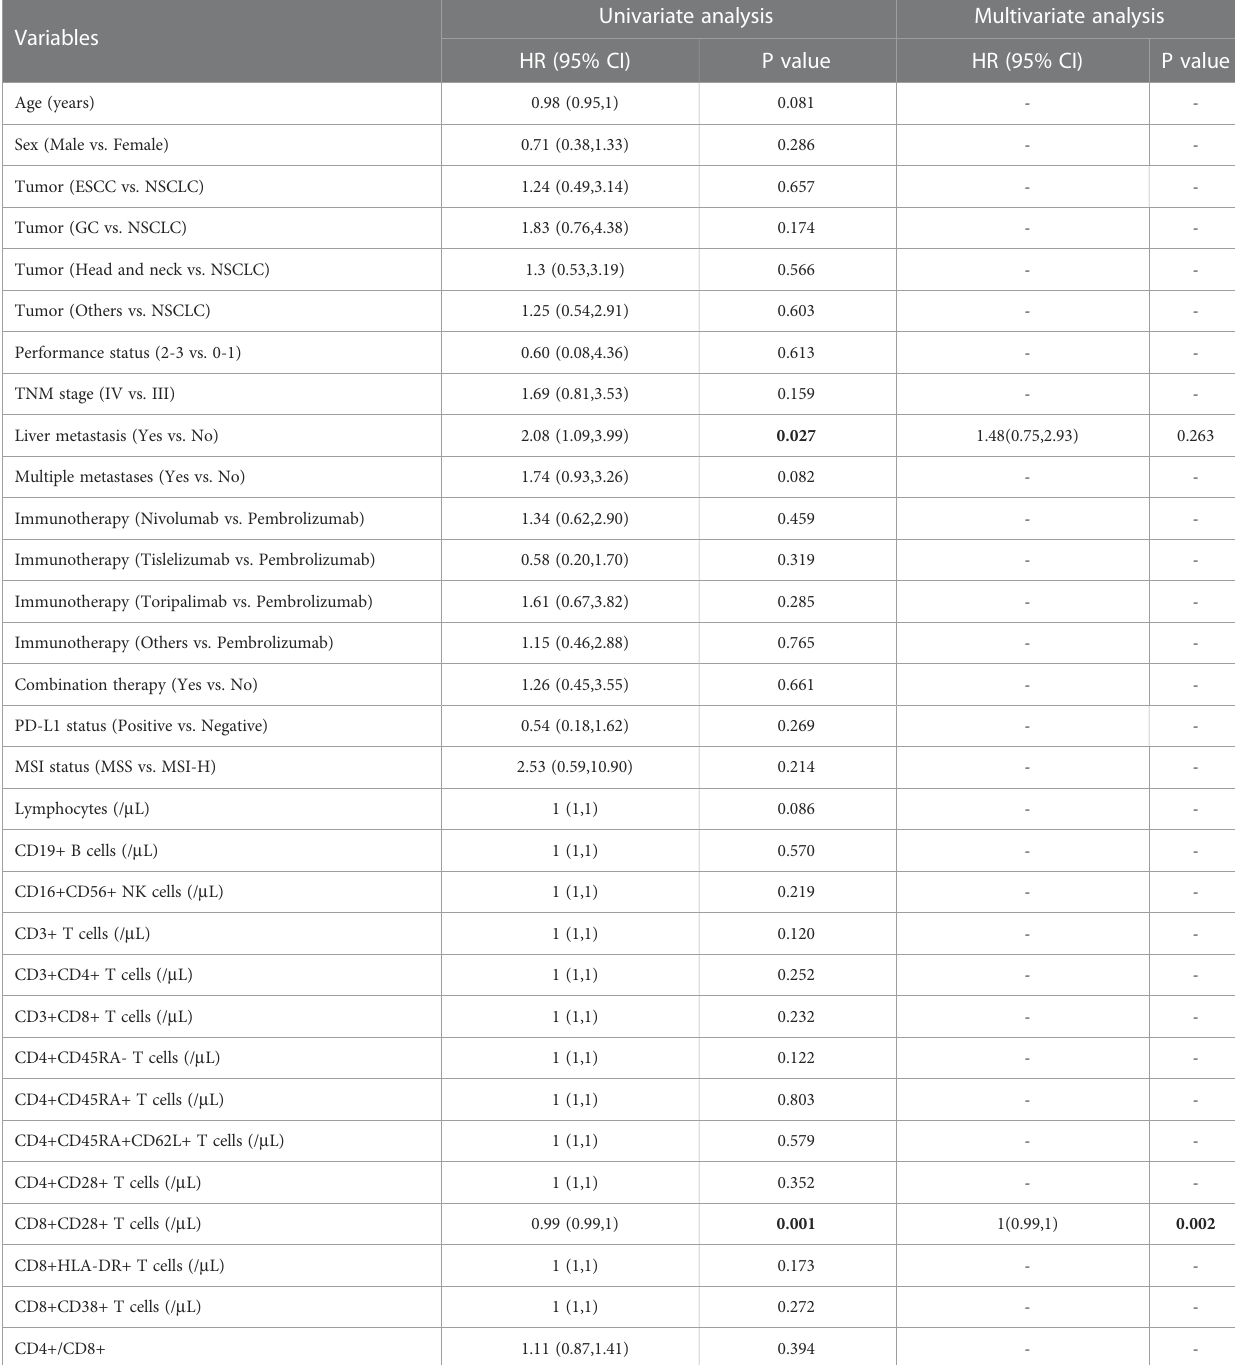
TABLE 3 Univariate and multivariate Cox analyses of factors for progression-free